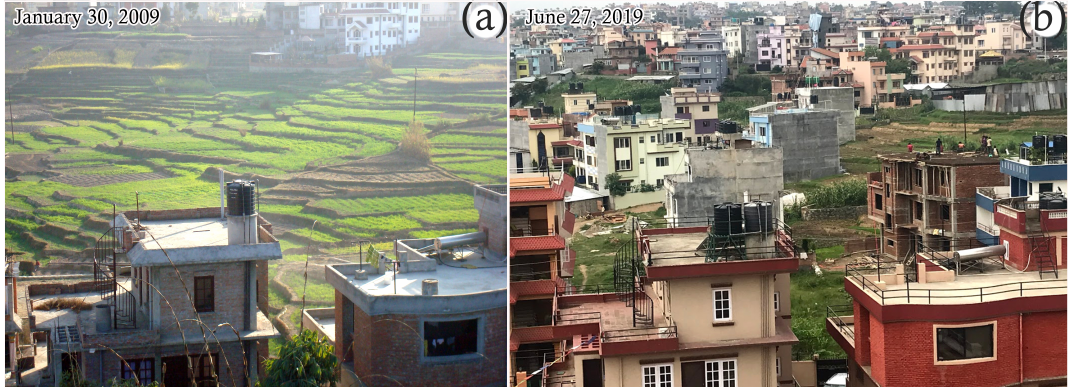
Figure 10. A repeat photo showing rapid expansion of the built-up areas of Khumaltar and Lalitpur (Lat: 27 ◦ 38 (cid:48) 48.83 (cid:48)(cid:48) , Lon: 85 ◦ 19 (cid:48) 21.92 (cid:48)(cid:48) ) between 2009 ( a ) and 2019 ( b